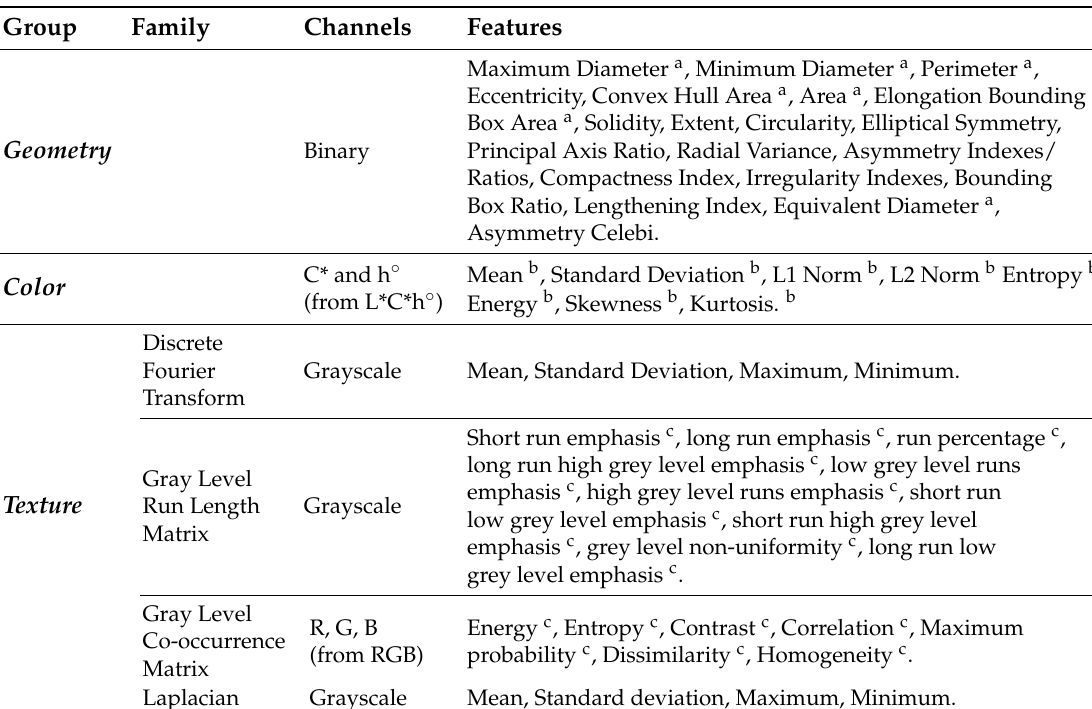
Table 3. Summary of the extracted image